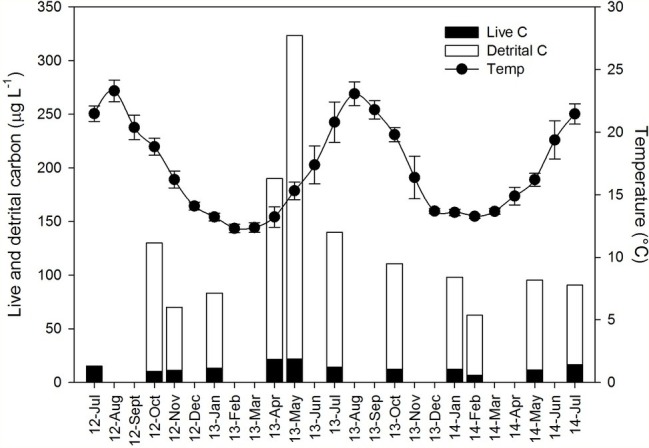
Ambient conditions and its seasonal variation during the sampling period (July 2012–July 2014) in the water column of the study area. Black dots represent the mean temperature (±SD). Particulate organic carbon concentration (μg C L−1) is presented as stack bars composed of live cells (black) and detrital carbon (empty). Detrital organic carbon was not quantified in the first sampling (July 2012).